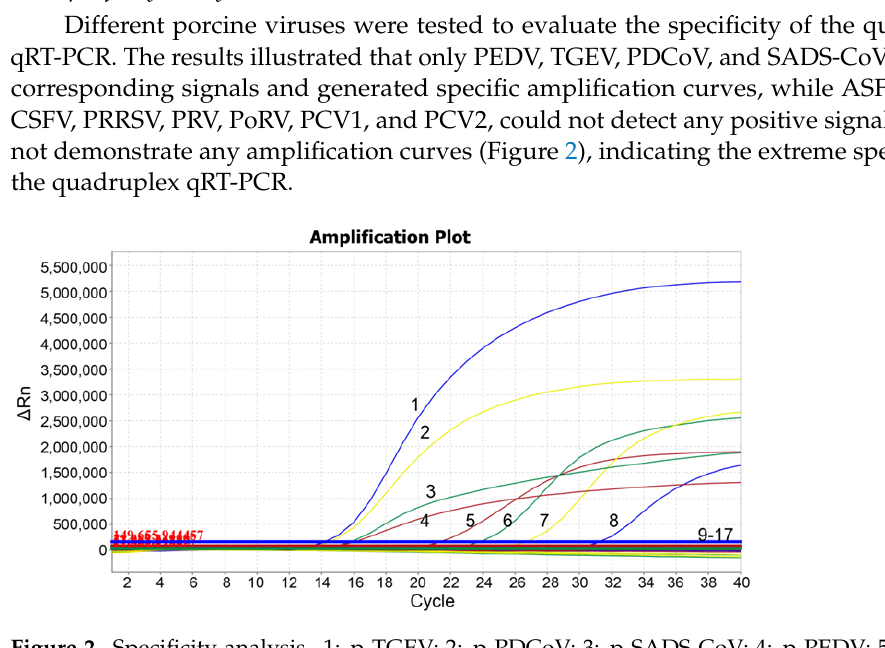
Figure 2. Specificity analysis. 1: p-TGEV; 2: p-PDCoV; 3: p-SADS-CoV; 4: p-PEDV; 5: PEDV; 6: